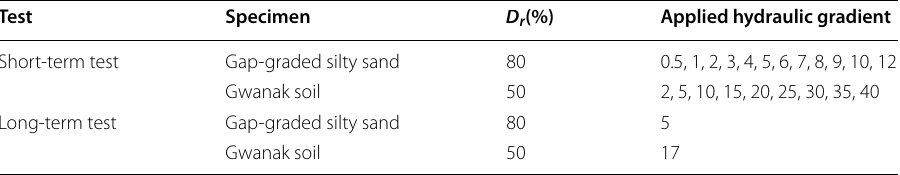
Table 2 Summary of the experiment program